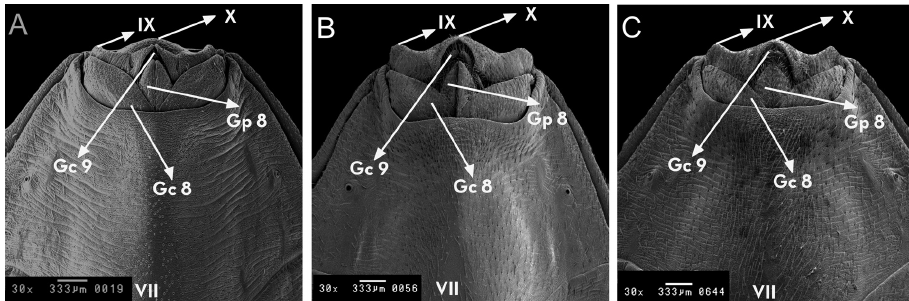
Figure 11. Female external genitalia, ventral side of R. marabaensis sp. n. ( A ), R. prolixus ( B ), R. robustus ( C ). Gc 8: gonocoxite VIII; Gc 9: gonocoxite IX; Gp 8: gonapofhyse VIII; VII, IX: esternites; X: segment.